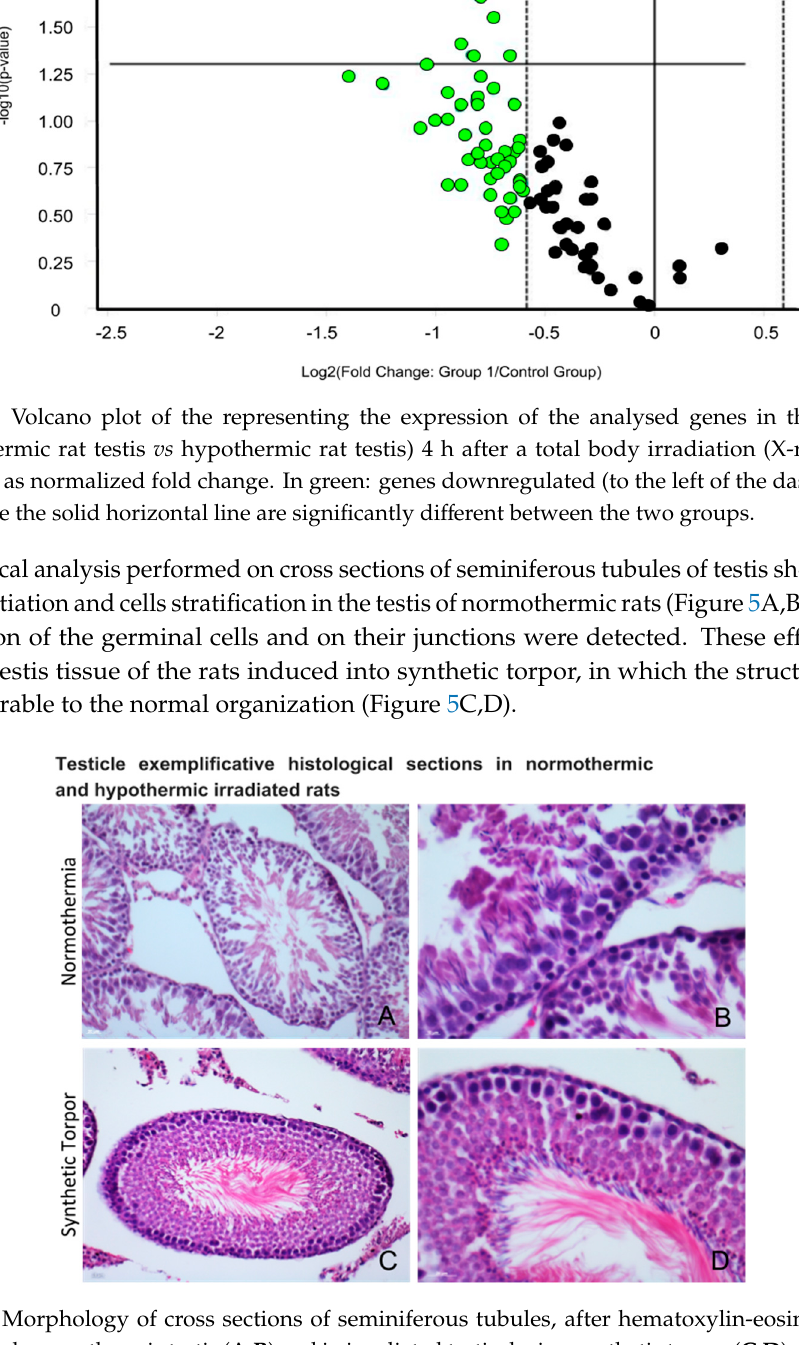
Figure 5. Morphology of cross sections of seminiferous tubules, after hematoxylin-eosin staining, in irradiated normothermic testis ( A , B ) and in irradiated testis during synthetic torpor ( C , D ). Alteration on the di ff erentiation and cells stratification were found in the testis of normothermic rats ( A , B ), in particular disorganization of the germinal cells and of their junctions was present. These e ff ects were not detected in the testis tissue of the rats induced into synthetic torpor, in which the structures could be comparable to the normal organization ( C , D